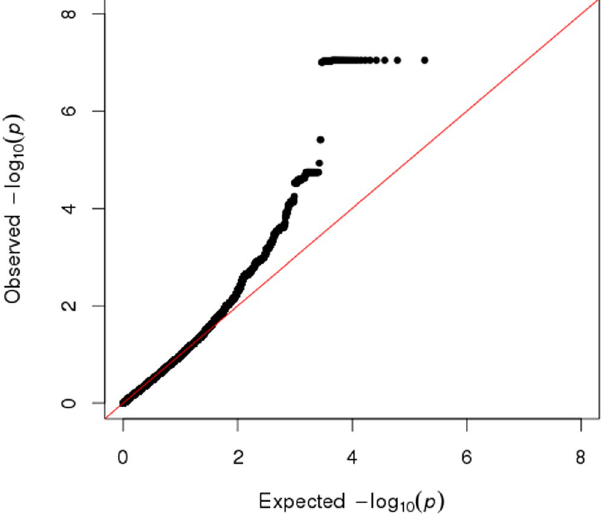
Figure 5. QQ plot showing observed versus expected − log 10 (p values) for association at all Neanderthal- derived loci of the shared variance of all Neanderthal-associated brain